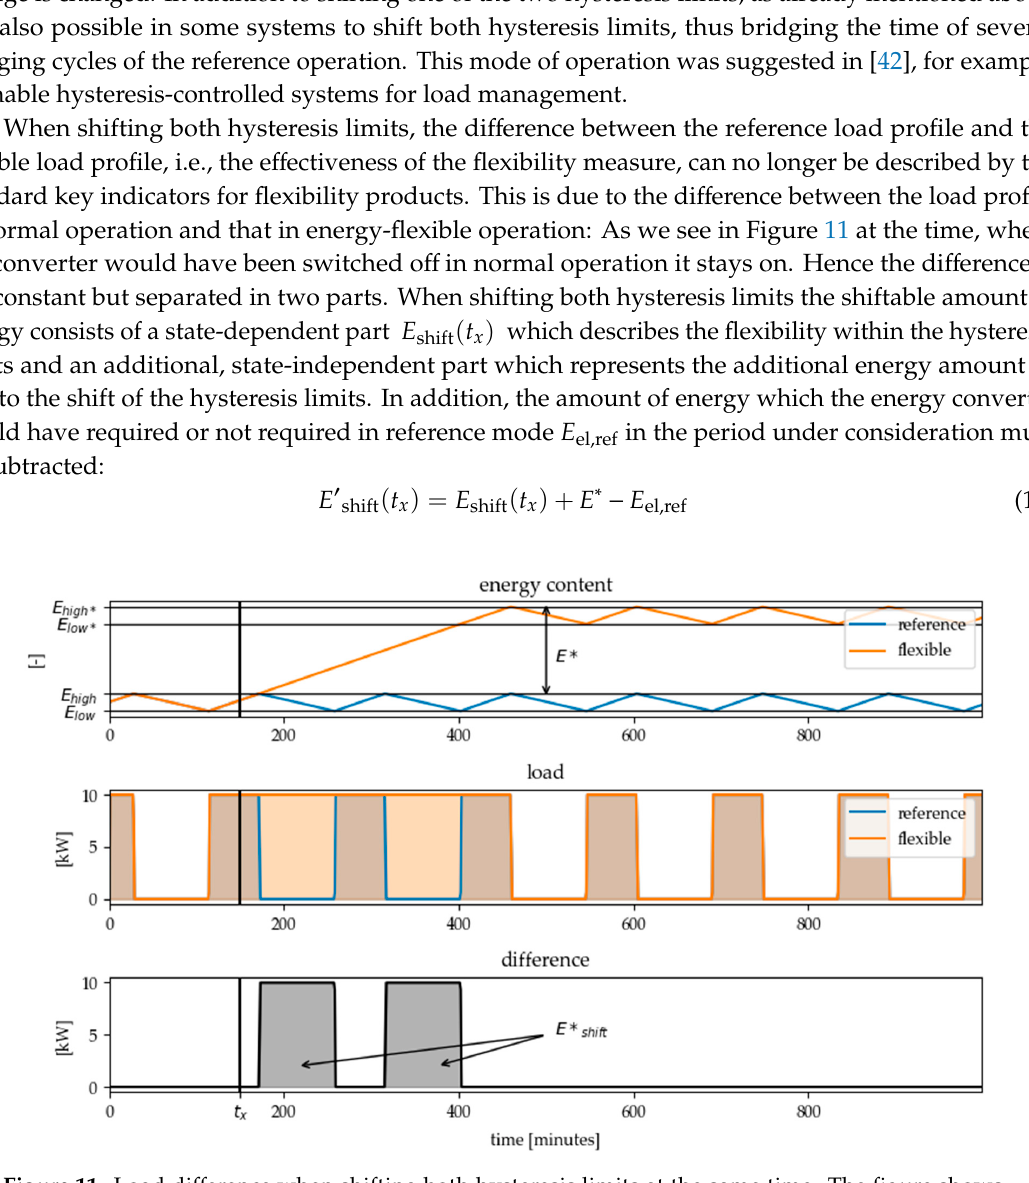
Figure 11. Load difference when shifting both hysteresis limits at the same time. The figure shows the results for the heated water tank example when shifting the temperature limits from 60–65 °C to 85–90 °C.